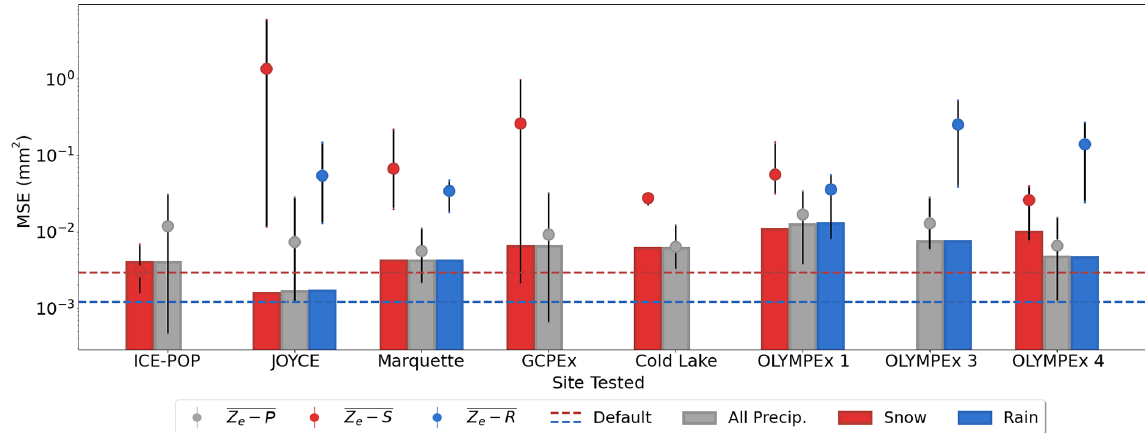
Figure 6. Leave-site-out full column DeepPrecip performance robustness analysis. Each bar represents a DeepPrecip full column log-scale MSE value when trained on all precipitation data, excluding the noted site, and then validated against said excluded site (the dashed line is the default DeepPrecip model with all sites). Each red and blue dot represents the average Z e − S/R relationship estimate tested in the same manner (error bars represent the min and max ensemble values). Gray dots represent the mean, min, and max ensemble values from all site-derived Z e − P relationships (excluding the relationship derived from site being tested), when applied to each